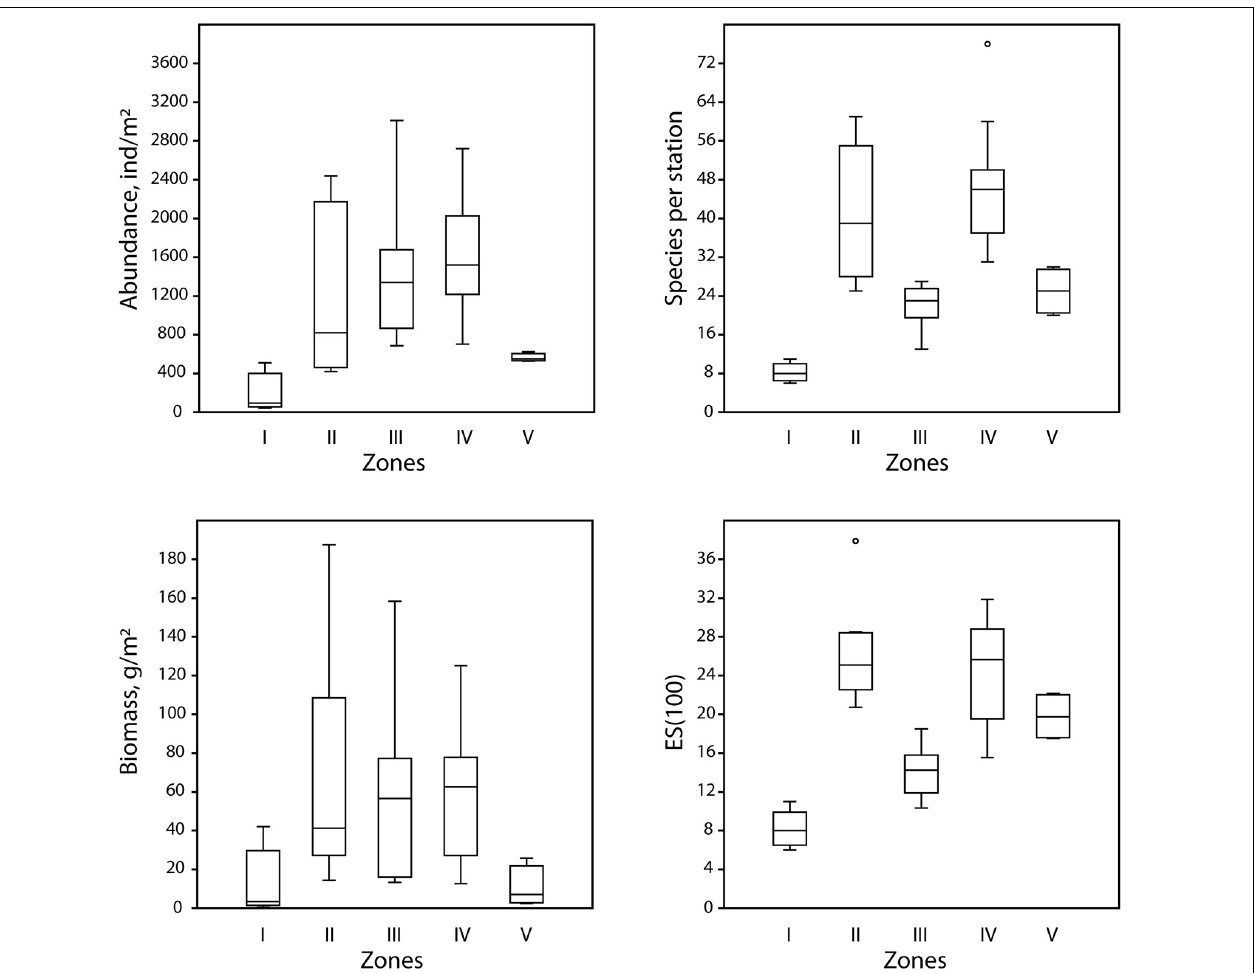
FIGURE 5 | Boxplots (the crossbar indicates the median value) illustrating mean values of the integral characteristics of five identified zones: abundance [ind/m 2 ), biomass (g/m 2 ), number of species per station (S), expected number of species per 100 individuals (ES(100)].